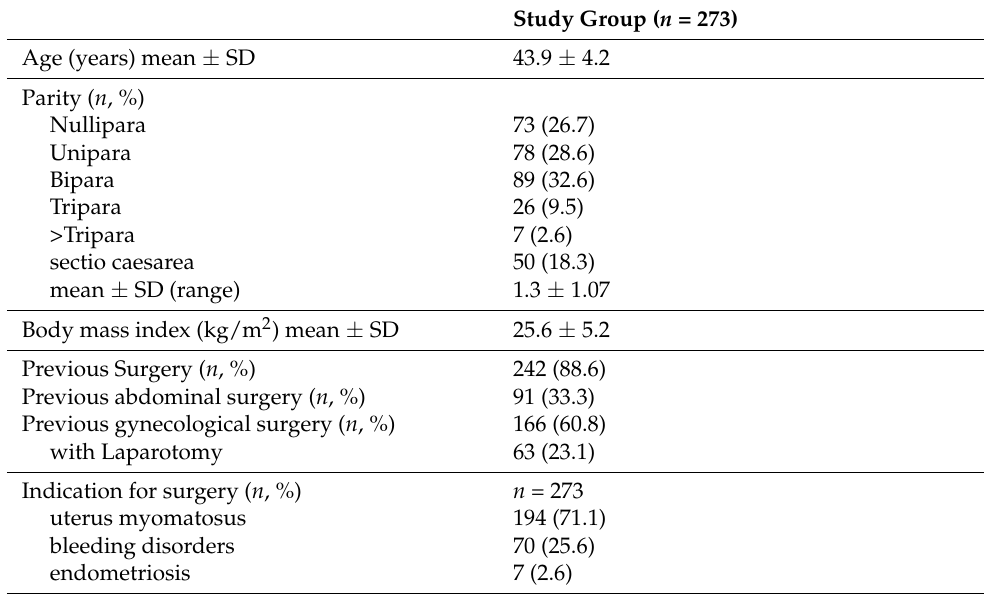
Table 1. Preoperative Characteristics of the Study